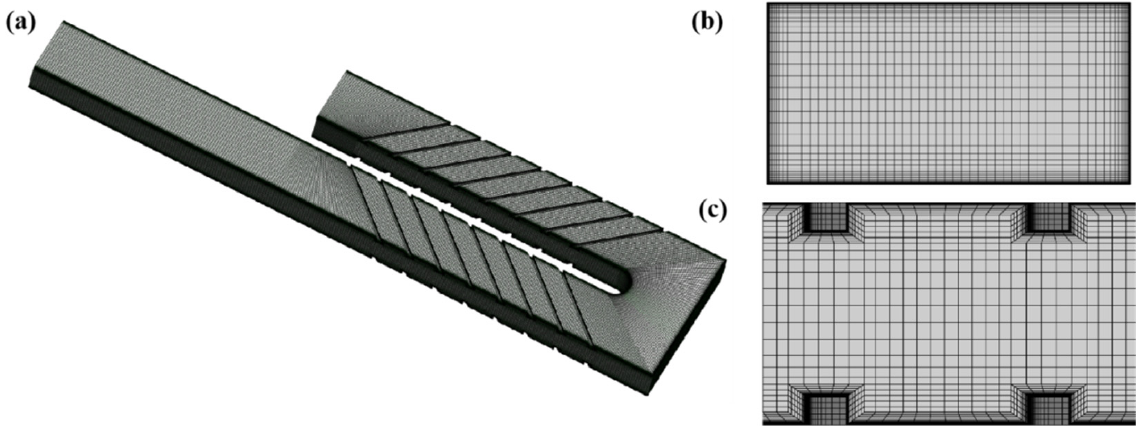
Figure 3. Mesh of ( a ) geometry ( b ) inlet section and ( c ) ribs region.